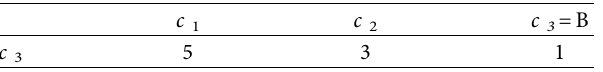
Table 3: Best-to-others